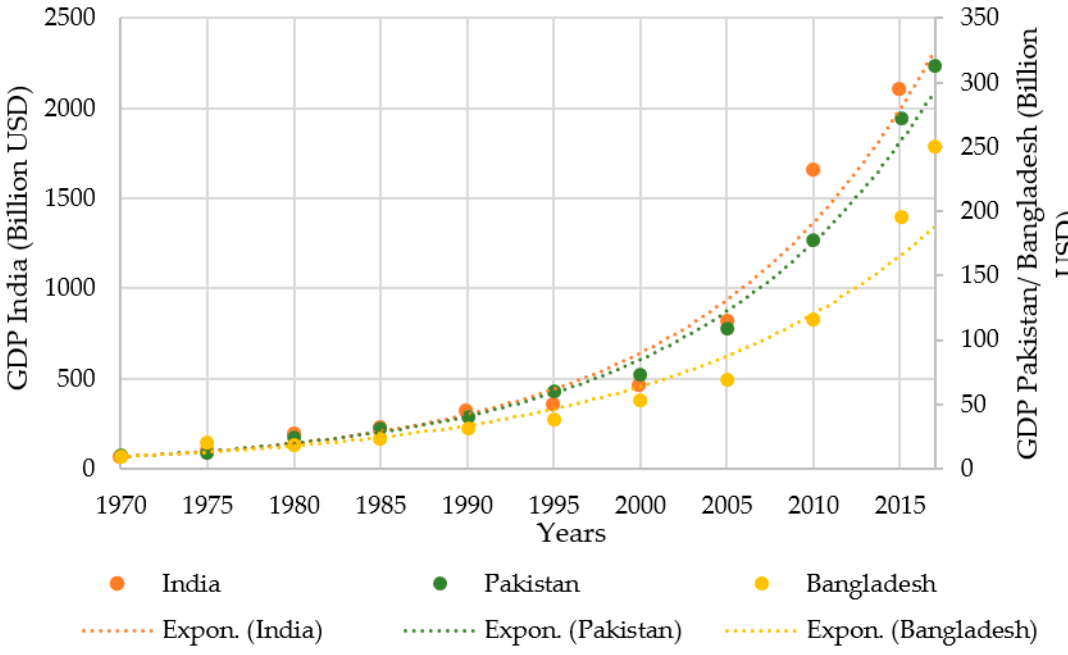
Figure 19. GDP of IPB shows exponentially trend in increase for each of IPB countries